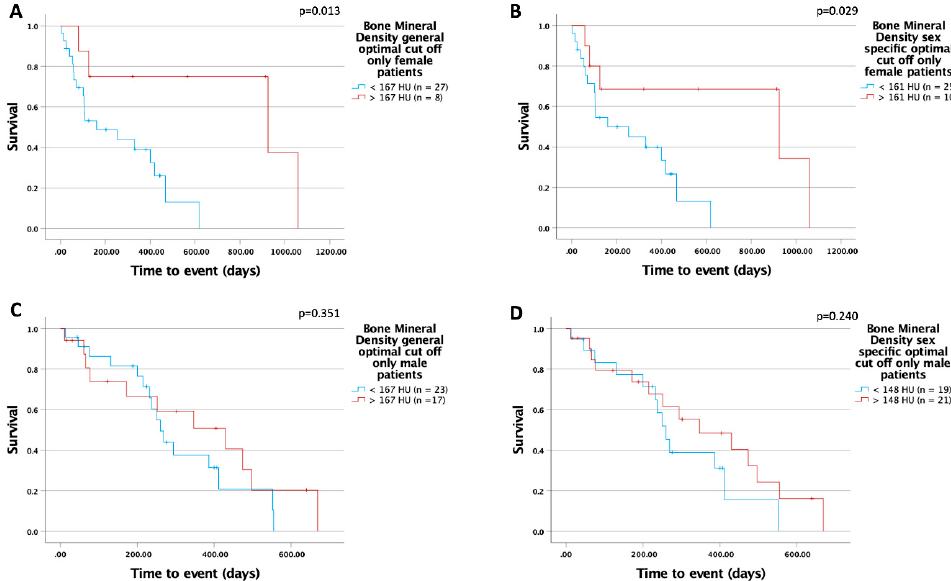
Figure 5. BMD is a sex-specific preoperative predictor of overall survival in patients with advanced CCA; ( A , C ) show the general optimal cut-off in subgroup analysis. Using a sex-specific cut-off value of 161 HU in the female subgroup, significant differences in overall survival were obtained ( B ). This was not the case in the male cohort ( D ). was not the case in the male cohort ( D